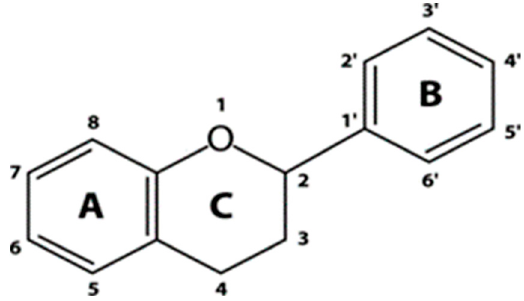
Figure 3. The general structure of flavonoids.